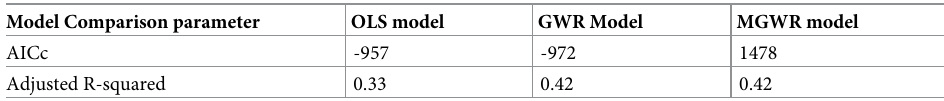
Table 5. Model comparison of OLS, GWR and MGWR